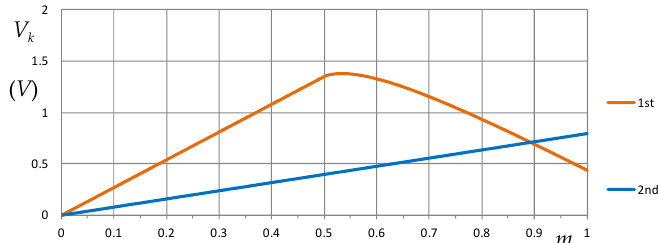
Figure 7. Amplitude of dominating low-frequency PV voltage harmonics as a function of the modulation index in case C H = 1 mH and I ac = 1 A.